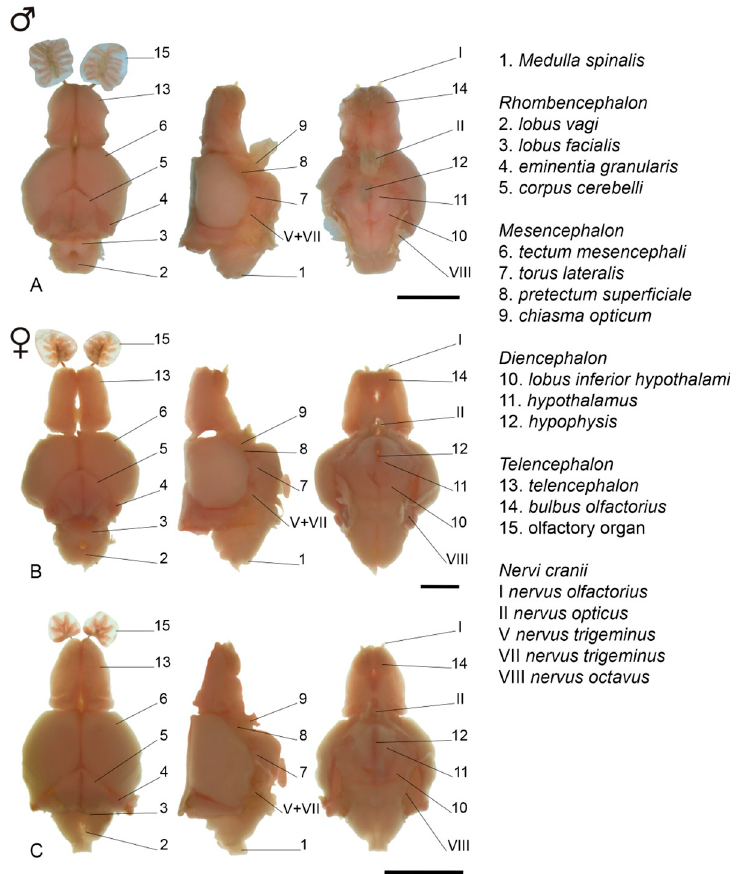
Fig 4. Gross brain morphology of Tyttobrycon shibattai MZUSP 125269, paratype. (A) mature male, 16.6 mm SL; (B) mature female, 19.8 mm SL; (C) juvenile specimen, 12.3 mm SL. From left to right: dorsal, lateral and ventral views. Scale bar 1